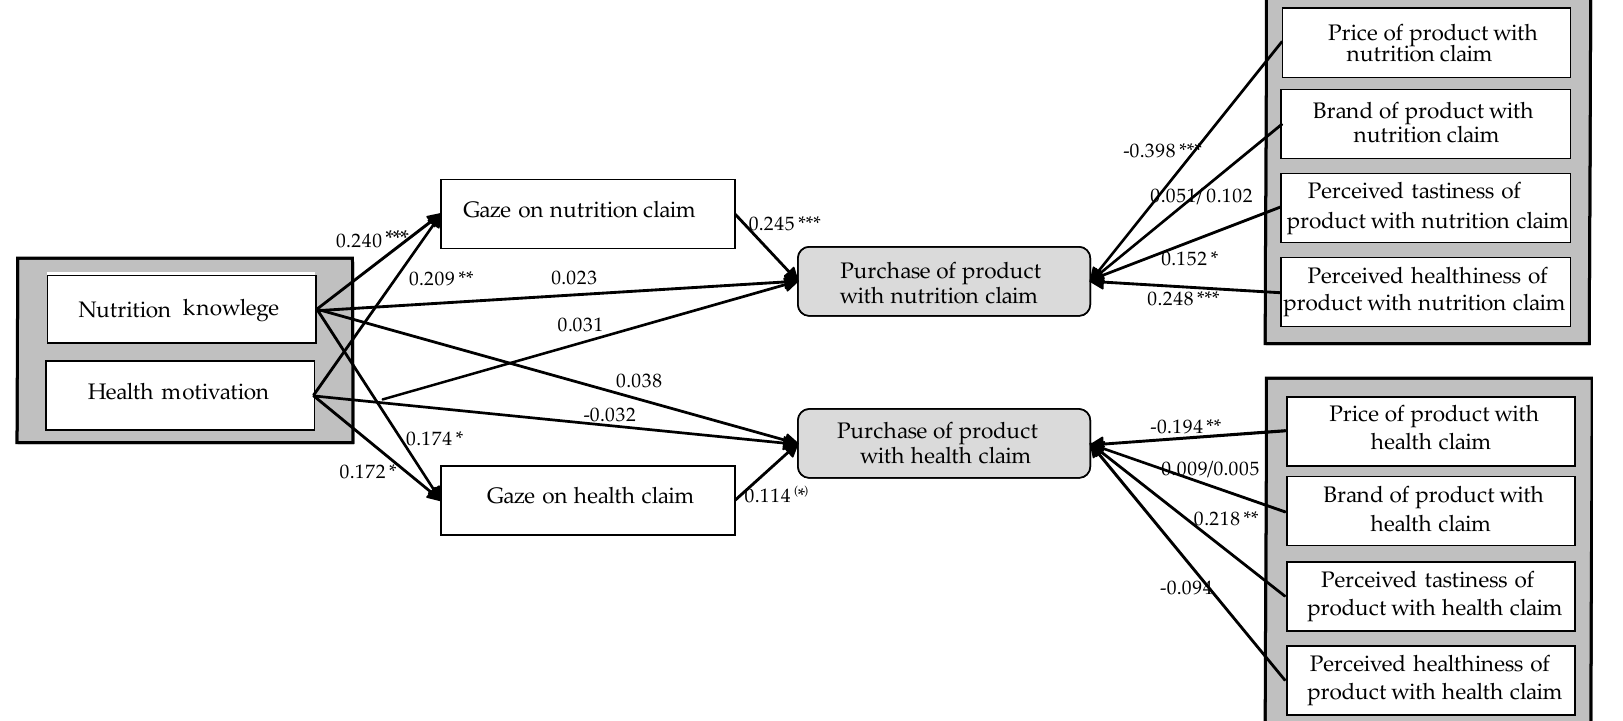
Figure 2. The structural equation model, including its path coe ffi cients and their significance. Significance p < 0.001 = ***; p < 0.01 = **; p < 0.05 = *; p < 0.1 = ( * )